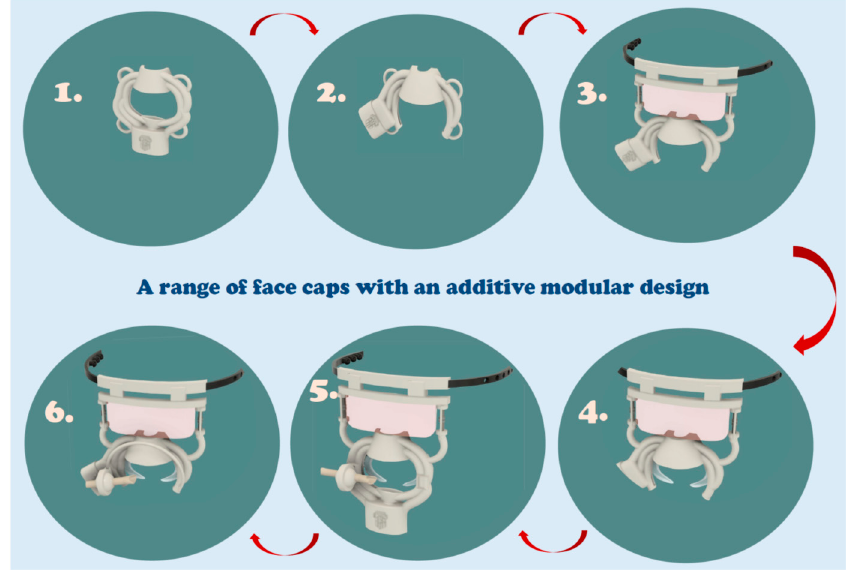
Figure 9. A range of face caps, each of which performs more and more integrated functions.